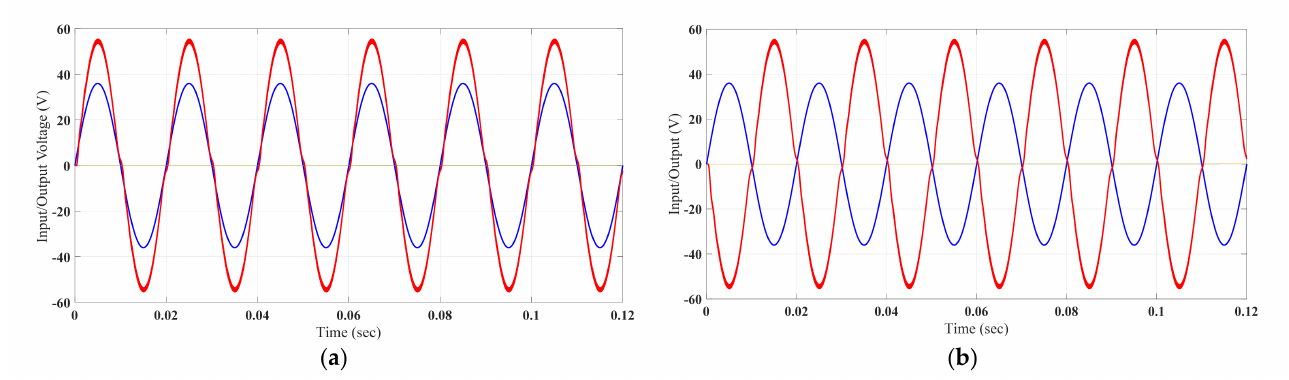
Figure 10. Simulation plotting input (blue) and output (red) during ( a ) non-inverting operation; ( b ) inverting